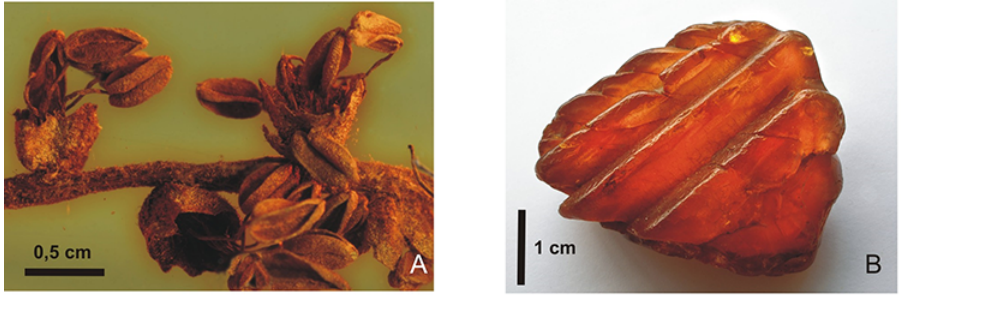
Figure 8 Flora in Baltic amber from the Museum of the Earth of the Polish Academy of Sciences